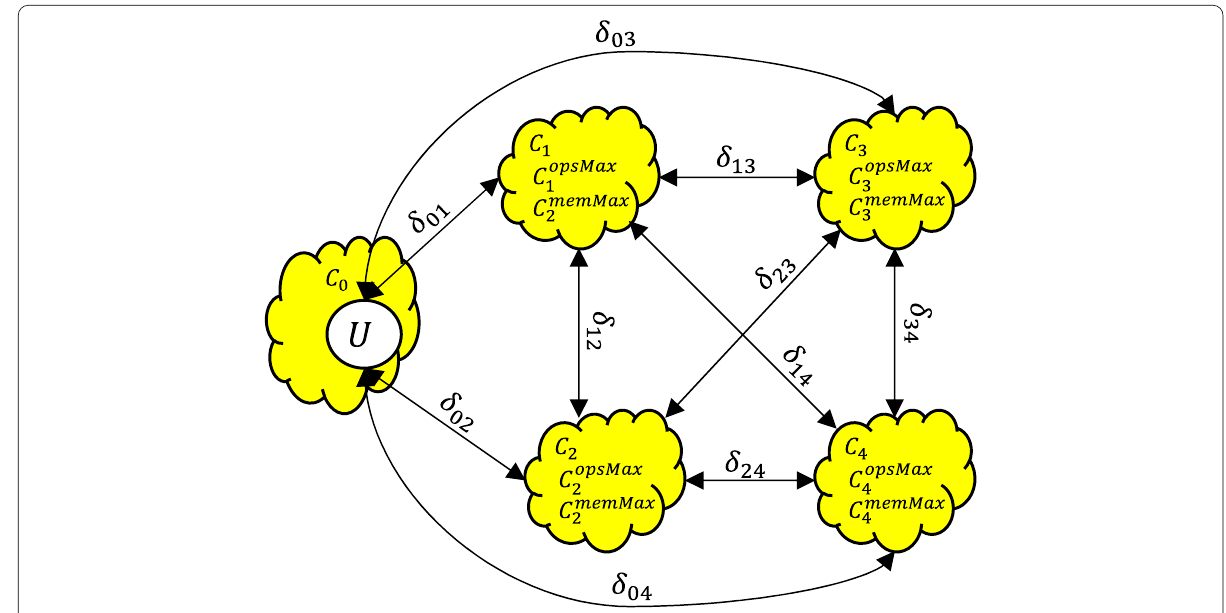
Fig. 2 The Multi-Cloud Model